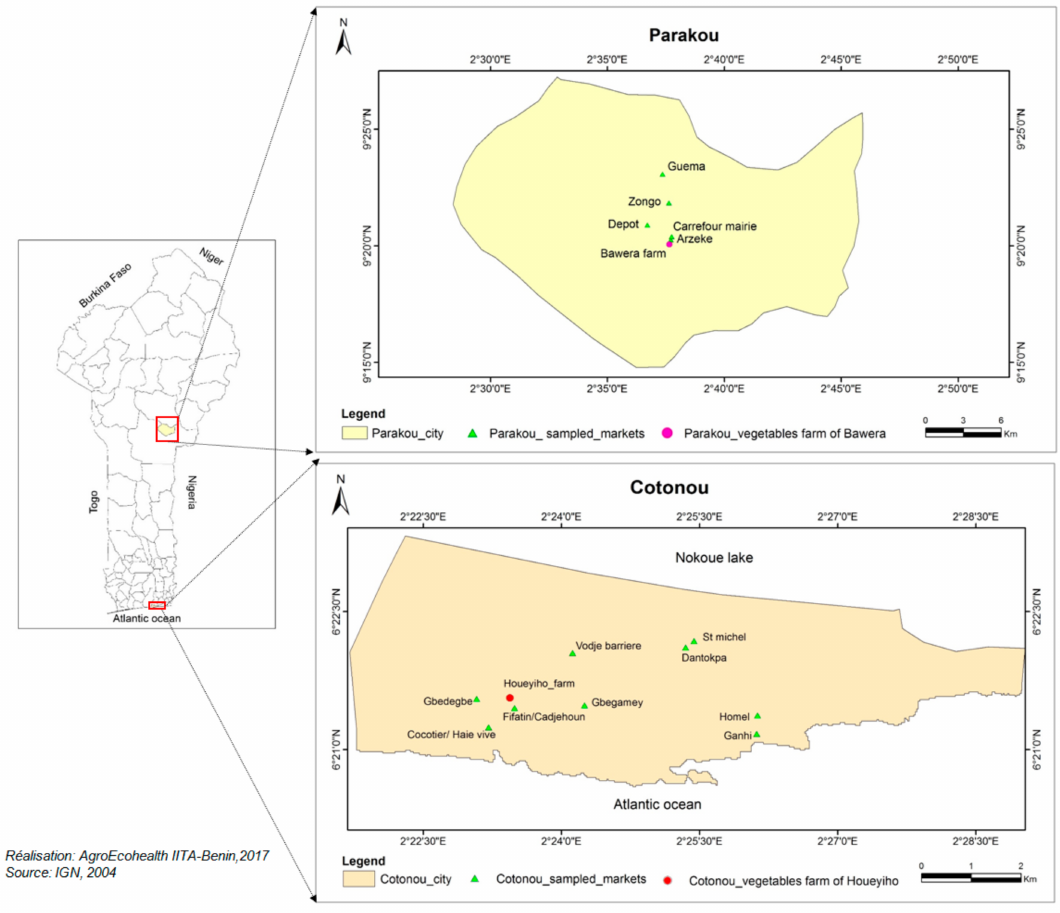
Figure 1. Map of sampling sites in the cities of Cotonou and Parakou in the Republic of